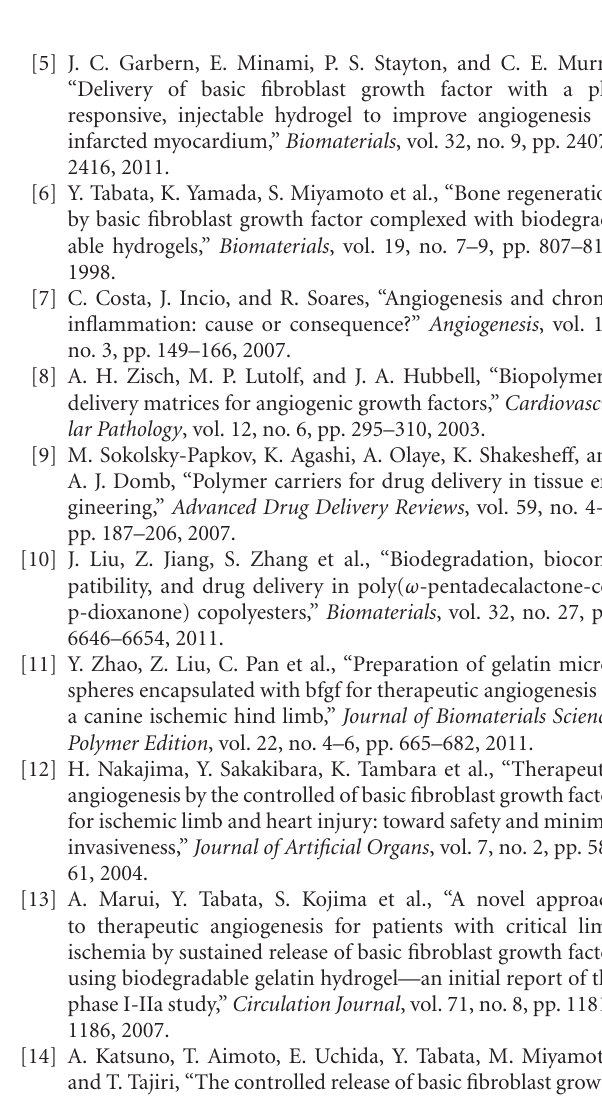
Figure 6: Immunohistochemical analysis for smooth muscle α -actin in ischemic hindlimbs 4 weeks after implantation. (a) No treatment; (b) bFGF; (c) CM; (d) bFGF-CM (bar = 100 μ m). (e) Histogram of the number of mature vessels in the ischemic, bFGF, CM, and bFGF-CM groups ( ∗ P < 0 . 05, ∗∗ P < 0 .